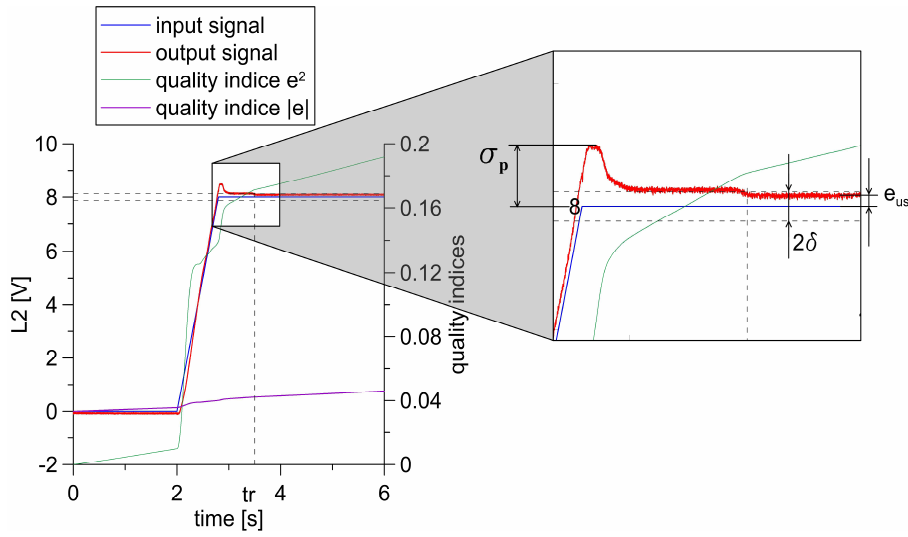
Figure 10. The dynamic characteristics and displacement analysis of actuator A2.